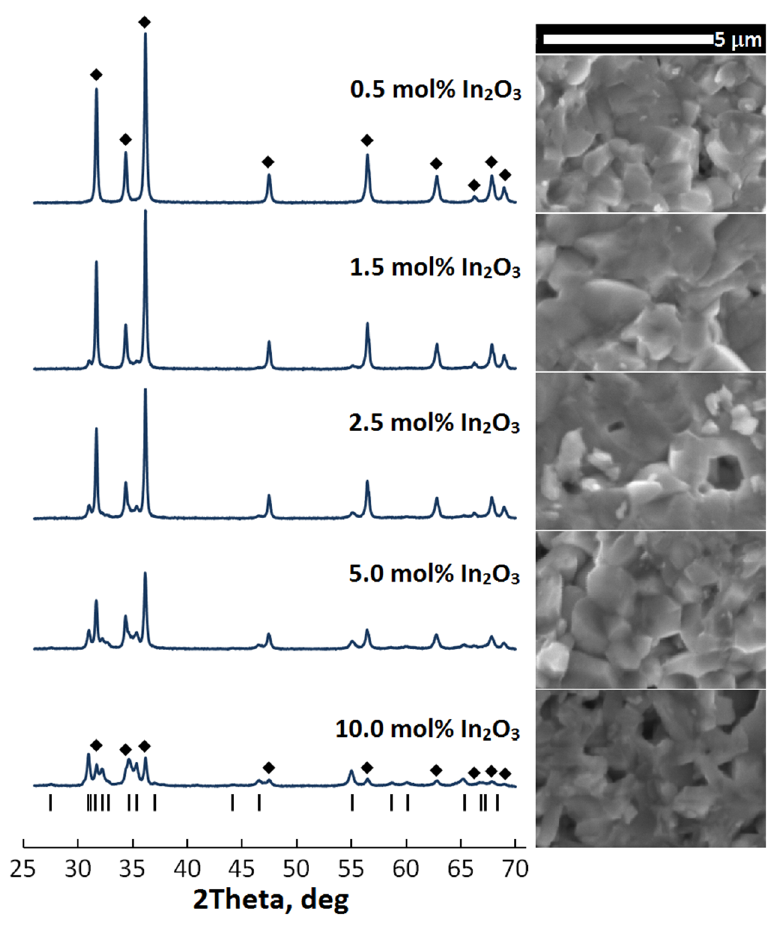
Figure 1. XRD spectra and SEM micrographs of ceramic samples with different In 2 O 3 content. In the spectra, the peaks corresponding to the hexagonal ZnO phase are marked with the symbol ♦ , and the positions of the most intense reflections of the secondary hexagonal In 2 Zn 5 O 8 phase are marked with black vertical lines.